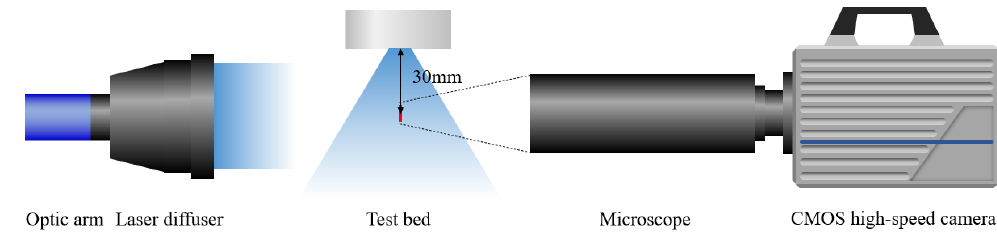
Figure 2. Experimental setup for SLIPI.